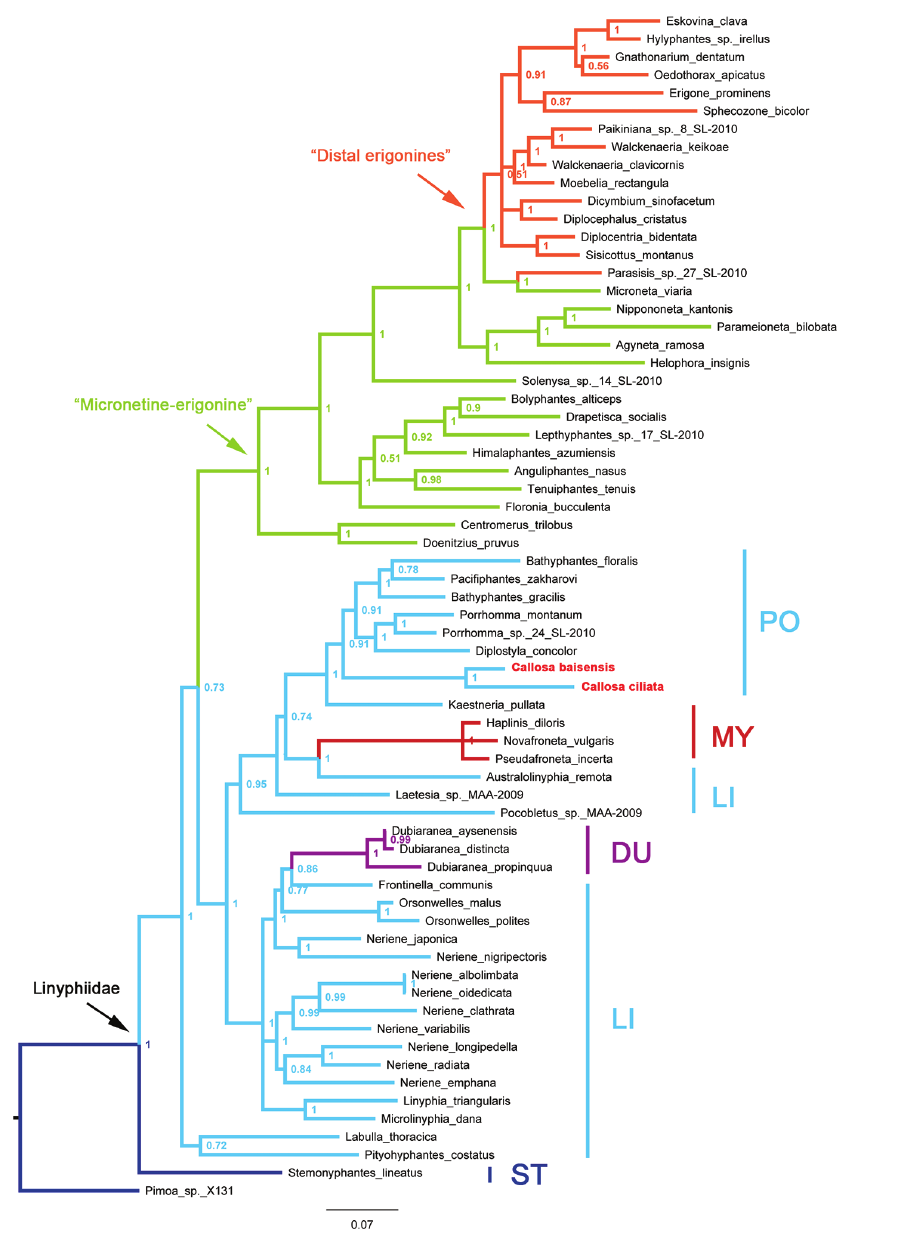
Figure 10. Phylogenetic tree reconstructed using Bayesian inference based on concatenated data. Numbers besides each node are posterior possibilities. Outgroup: Pimoa sp. X131 (dark blue) DU Dubiaraneinae (purple) LI Linyphiinae (blue) MY Mynogleninae (red) PO Porrhommini (blue) ST Stemonyphantinae (dark blue). “Micronetines-erigonines” clade is presented in green, the “distal erigonines” clade is colored in orange. Taxa with sequences downloaded from NCBI are listed at the end of each branch in black accord- ingly, and Callosa gen. n. species are marked in